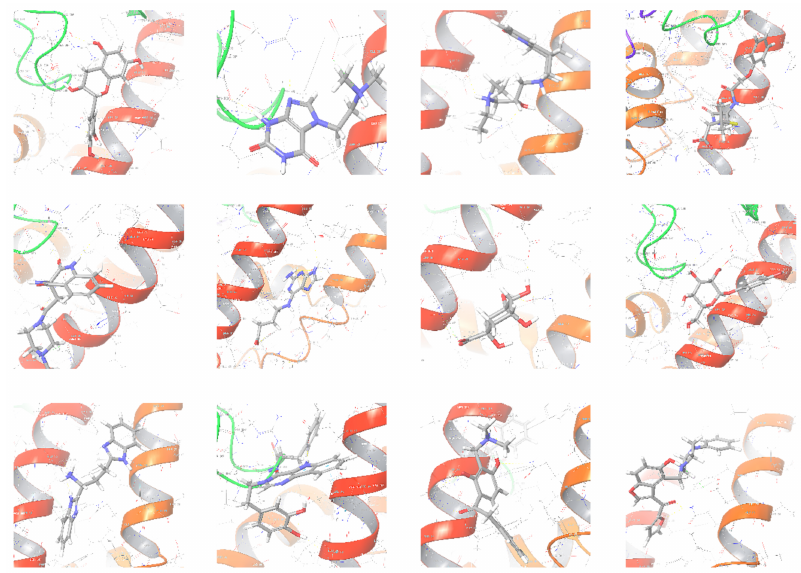
Figure 2. The interactions between the receptor and the 12 top ligands. The yellow line shows a hydrogen bond, the blue lines show π - π interactions, and the green lines show salt bridges.